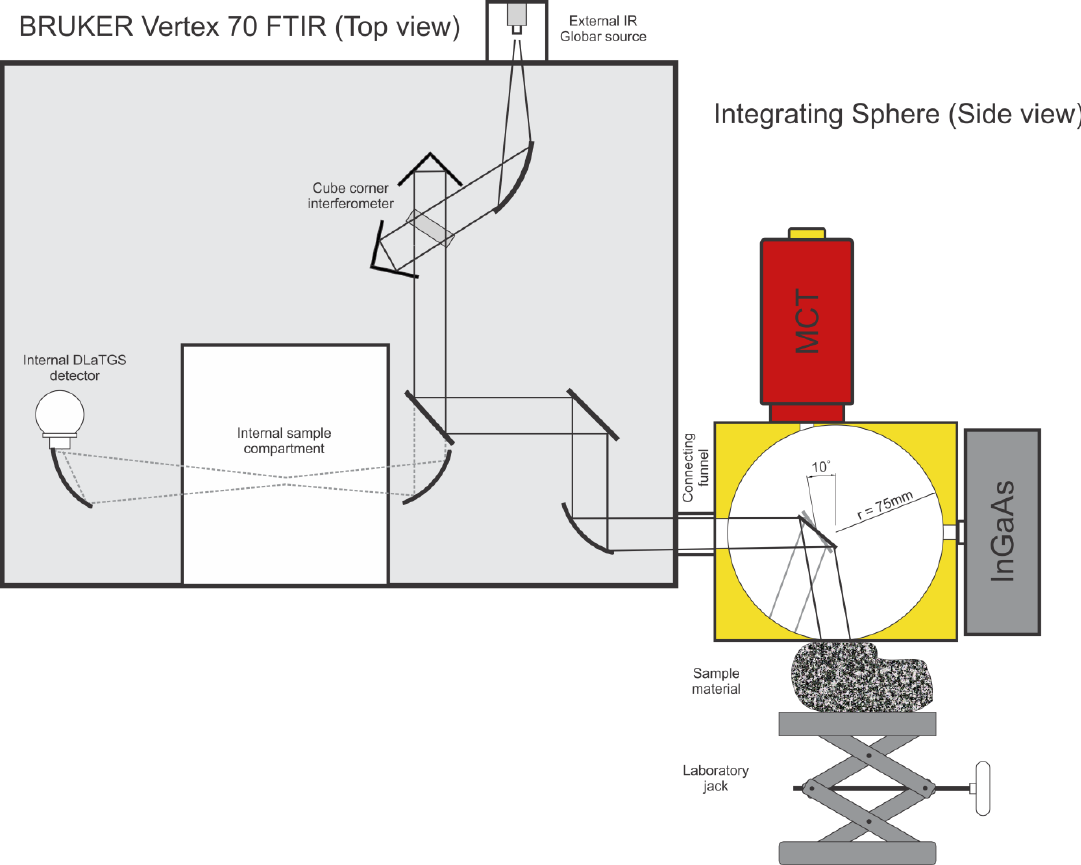
Figure 2. Sketch of instrument setup and internal beam path. The gray beam path inside the sphere illustrates the comparative calibration method in which the sphere wall is used as the